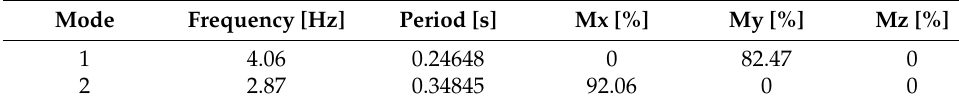
Table 5. Modal analysis information—strengthened structure.